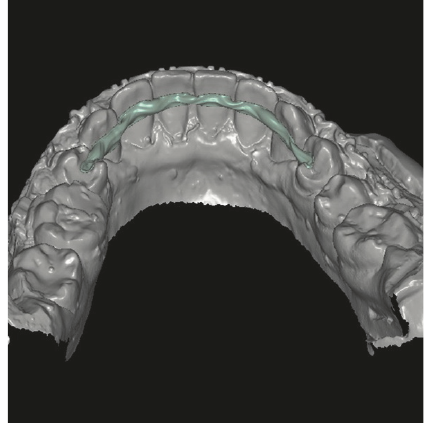
Figure 2: Virtual CAD/CAM zirconium bar